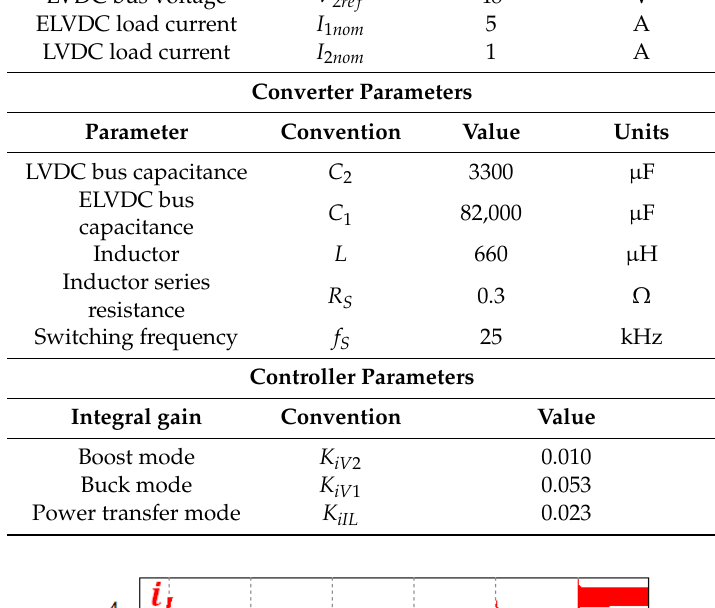
Table 1. Parameters of the system.